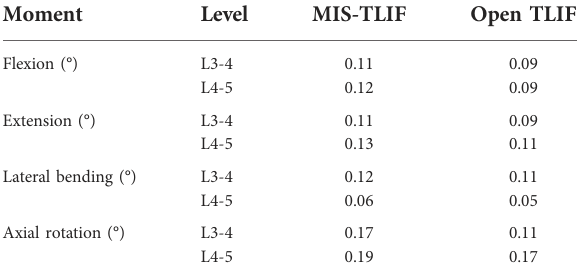
TABLE 7 Range of motion in 2-level